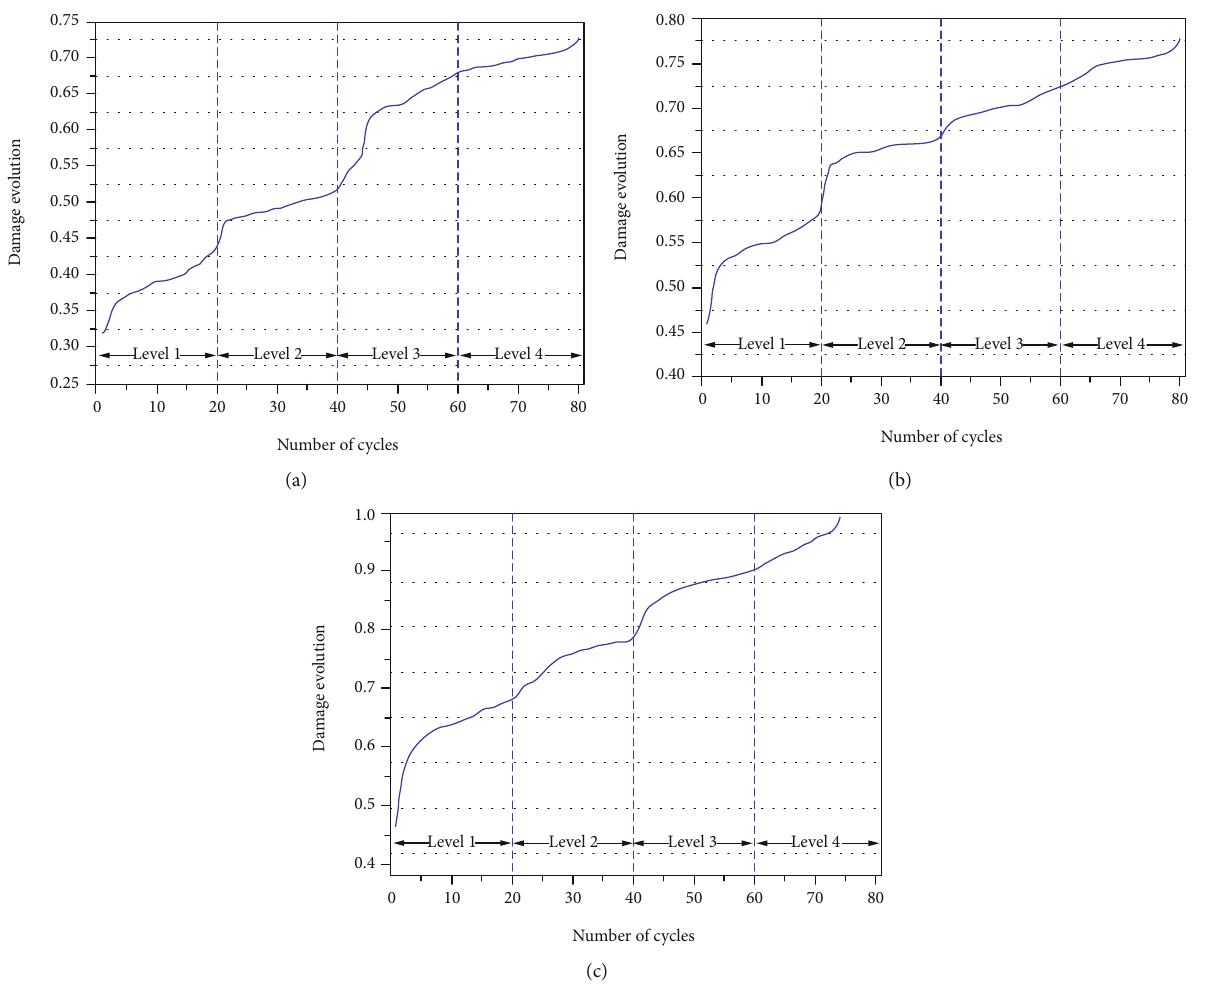
Figure 13: Evolution of cumulative damage versus number of cycles at di ff erent loading frequencies: (a) 0.1Hz; (b) 0.2Hz; (c) 0.5Hz. Table 1: Fitting results versus relative cycle at di ff erent loading frequencies under multilevel cyclic